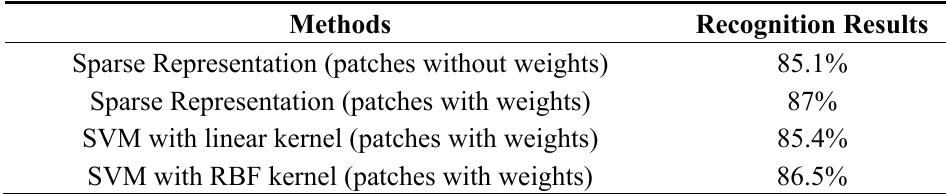
Table 2. Comparisons between SR and